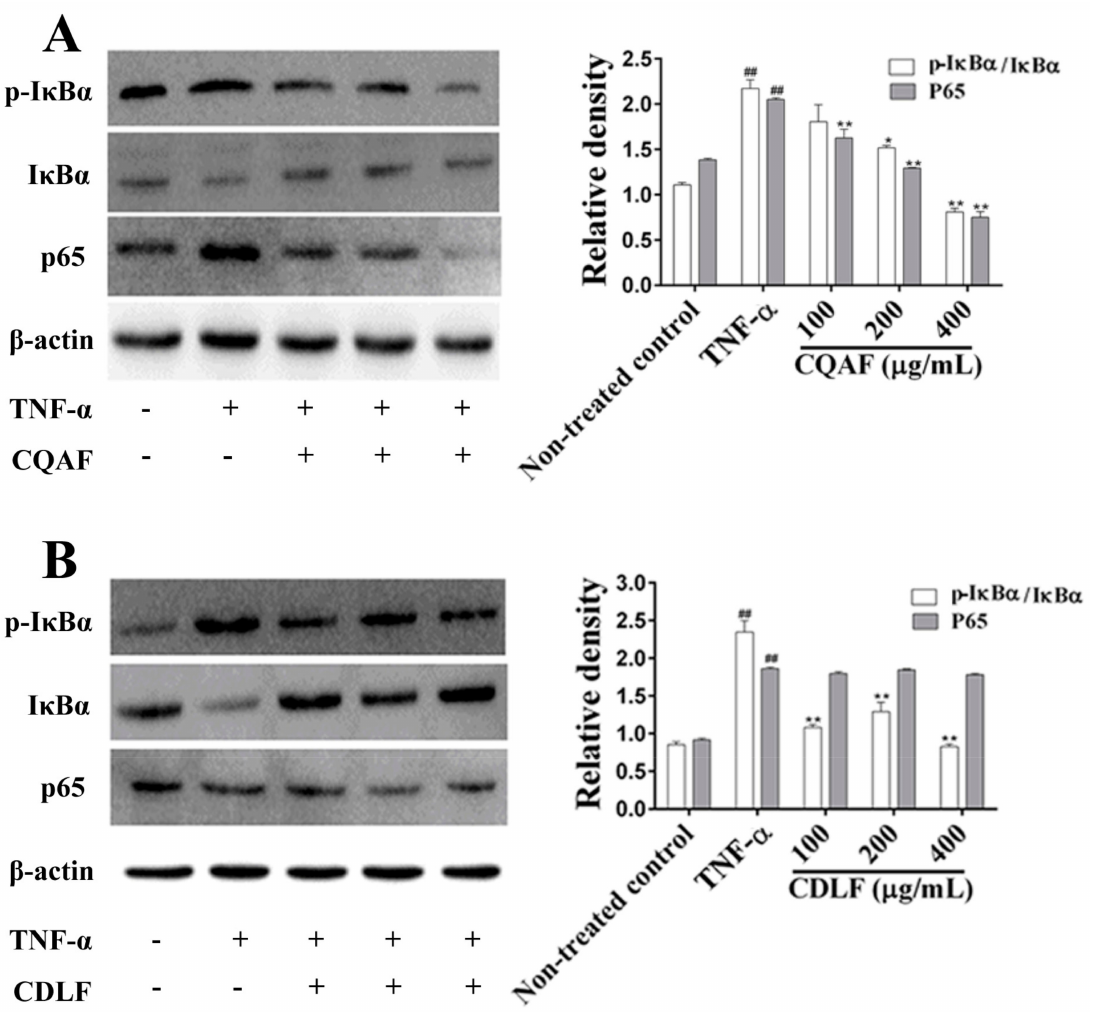
Figure 8. Effects of CDLF and CQAF on the expression of the p65 protein and I κ B phosphorylation in MH7A cells. The cells were treated with CDLF or CQAF at various concentrations (100–400 µ g/mL) for 24 h in the presence of TNF- α (50 ng/mL). β -Actin was used as the internal control. ( A ) CQAF treatment; ( B ) CDLF treatment. The data are presented as the mean ± SD ( n = 3) when compared with the non-treated control group. ## p < 0.01 when compared with the non-treated control group; * p < 0.05, ** p < 0.01 when compared with the TNF- α group. Original figures and numeric data can be found in Supplementary Materials Figures S7–S14 and Tables S9 and S10,